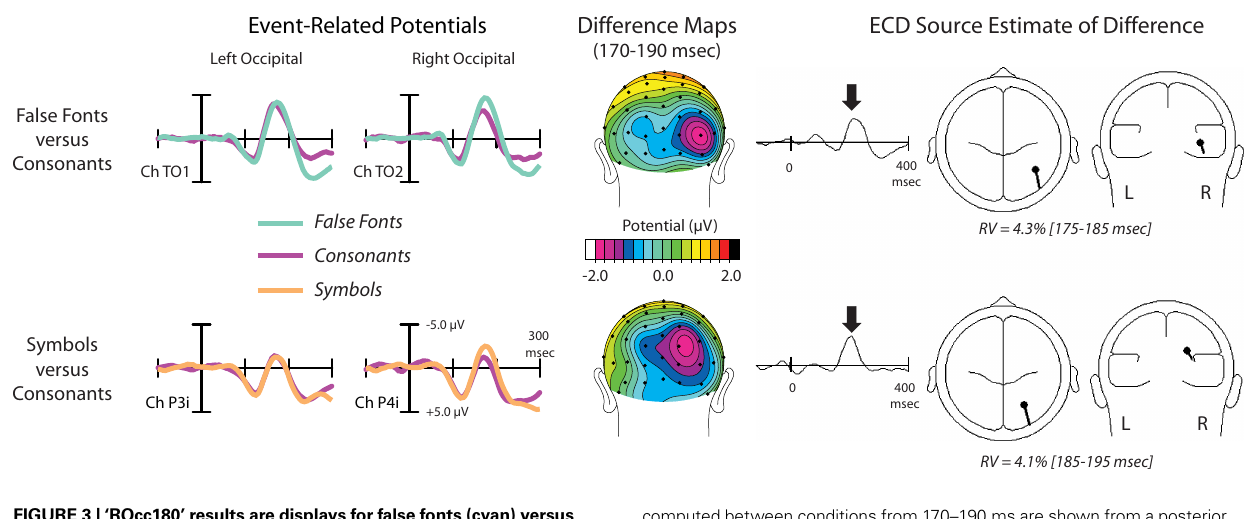
FIGURE 3 | ‘ROcc180’ results are displays for false fonts (cyan) versus consonants (magenta) on top and symbols (orange) versus consonants (magenta) on the bottom. Left panels: Grand average ERPs at a pair of left and right occipital sensors [Note that slightly different sensor locations are used for the two different contrasts.] Middle panels: Difference maps